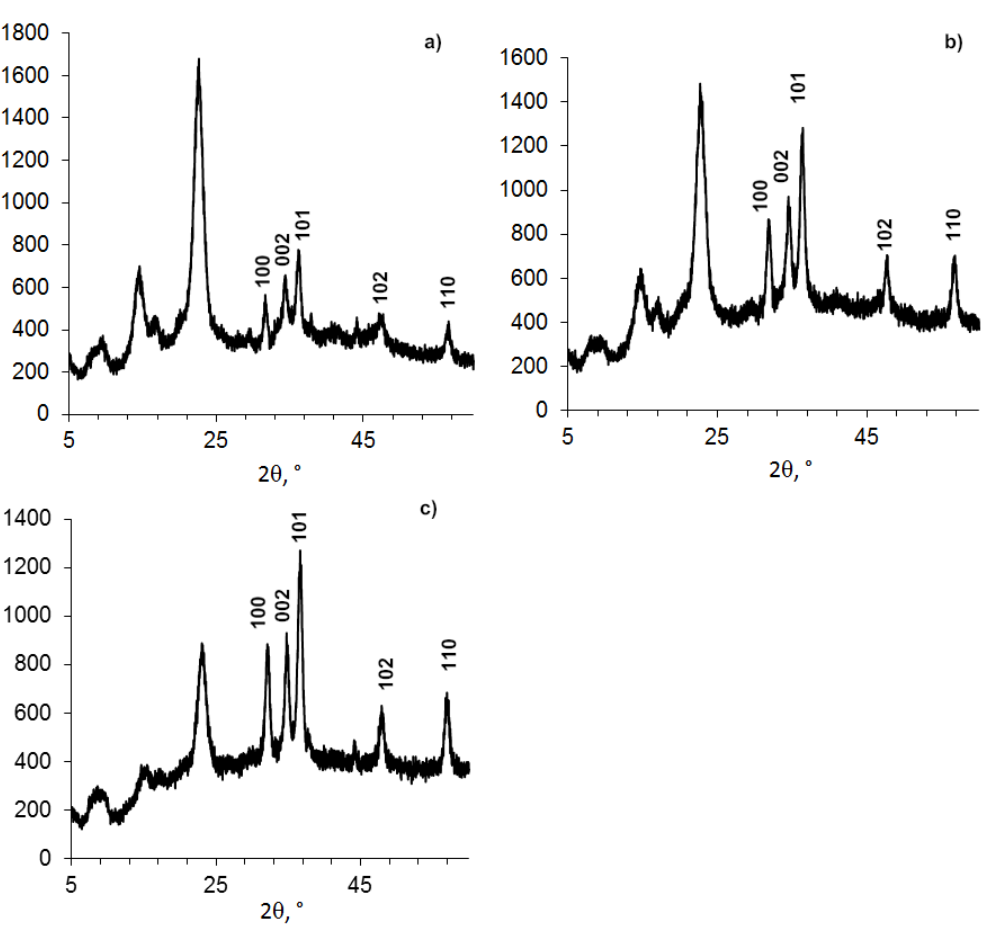
Figure 3. Powder XRD patterns of compositions (BC-ZnO NPs) samples, with concentrations of ZnO NPs: a ). 6.6%; b ). 16.9%; c ). Table 4. Data of Figure 3.